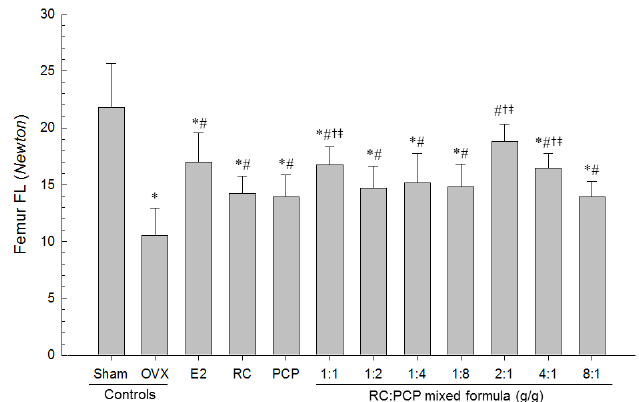
Figure 8. Femur FL in Sham-operated or OVX ddY mice. Values are expressed mean ± S.D. of eight mice. OVX = Ovariectomy; E2 = 17β-estradiol; RC = Red clover dry extracts; PCP = Pomegranate Concentrate Powder; RC:PCP = Mixed formulations consisted of RC and PCP (g/g); FL = Failure load, bone strength. * p < 0.05 as compared with sham control; # p < 0.05 as compared with OVX control; † p < 0.05 as compared with RC single formula treated mice; ‡ p < 0.05 as compared with PCP single formula treated